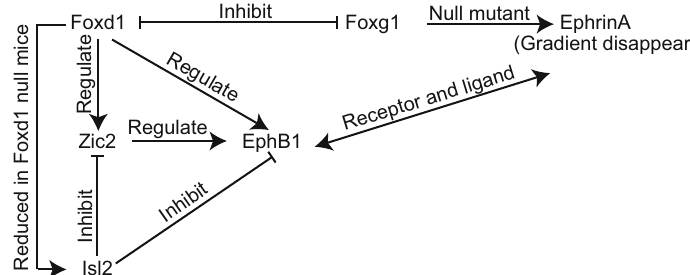
Figure 3. Network of genes and molecules during the path fi nding of RGC axons at the optic